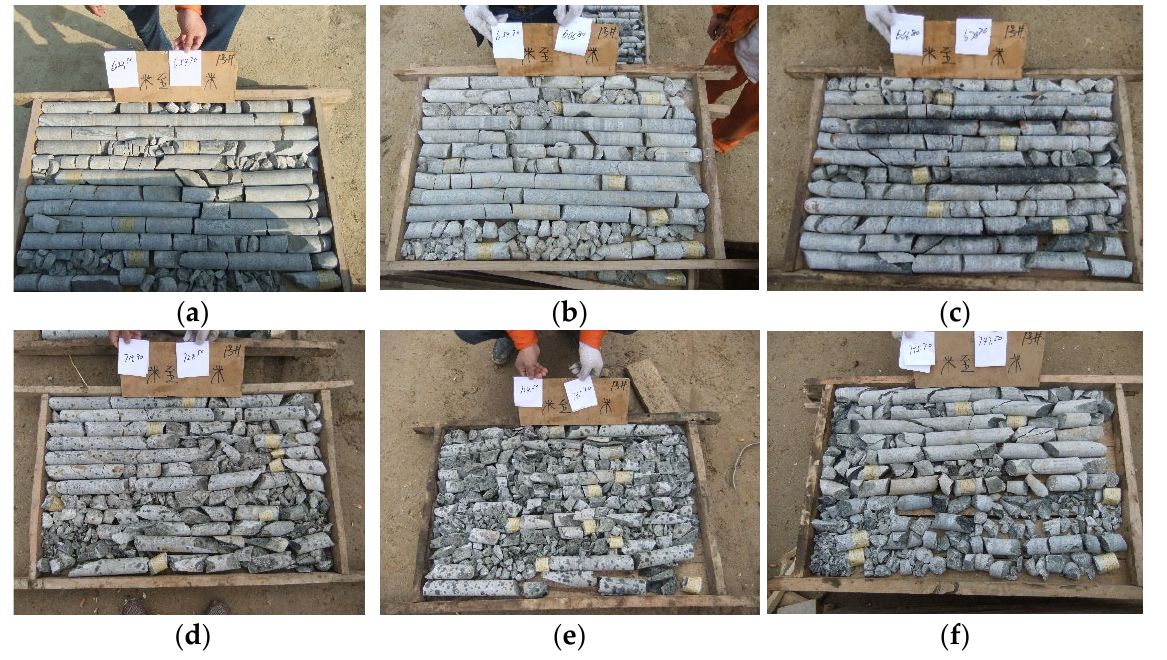
Figure 11. Rock mass samples revealed by on-site drilling. ( a ) 643.40 m–654.70 m; ( b ) 654.70 m–666.80 m; ( c ) 666.80 m–678.70 m; ( d ) 713.30 m–724.50 m; ( e ) 724.50 m–735.70 m; ( f ) 735.70 m–747.50 m.